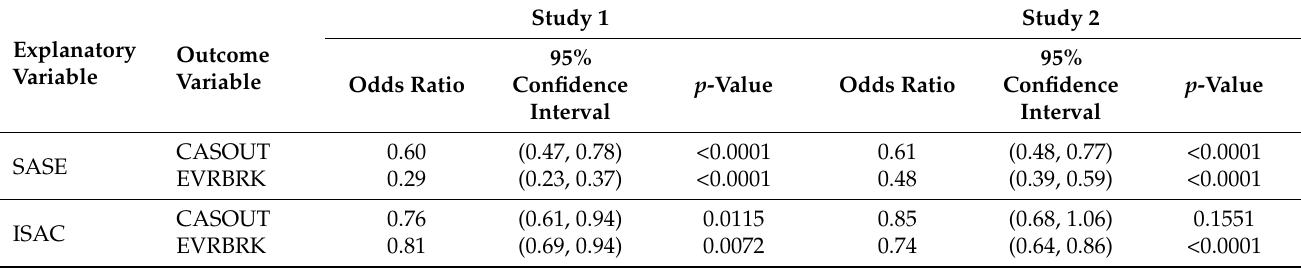
Table 4. Associations of SASE and ISAC with self-reported sexual risk